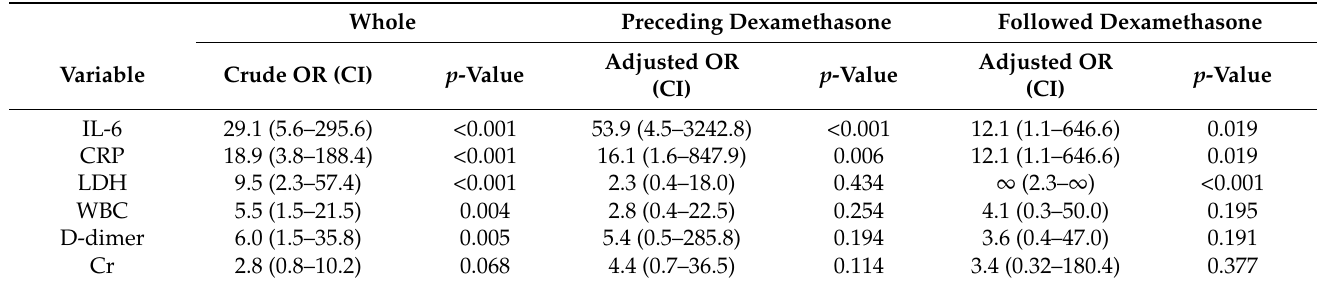
Table 4. The odds ratio of each marker for all patients and adjusted for preceding and followed dexamethasone therapy.